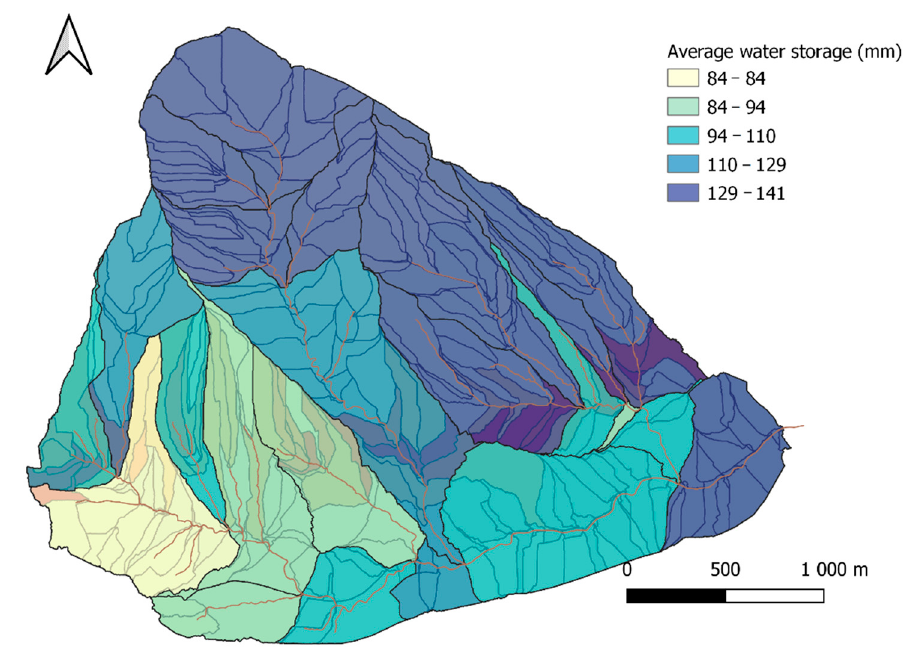
Figure 7. Level of water storage in aquifer for Smugawka catchment.